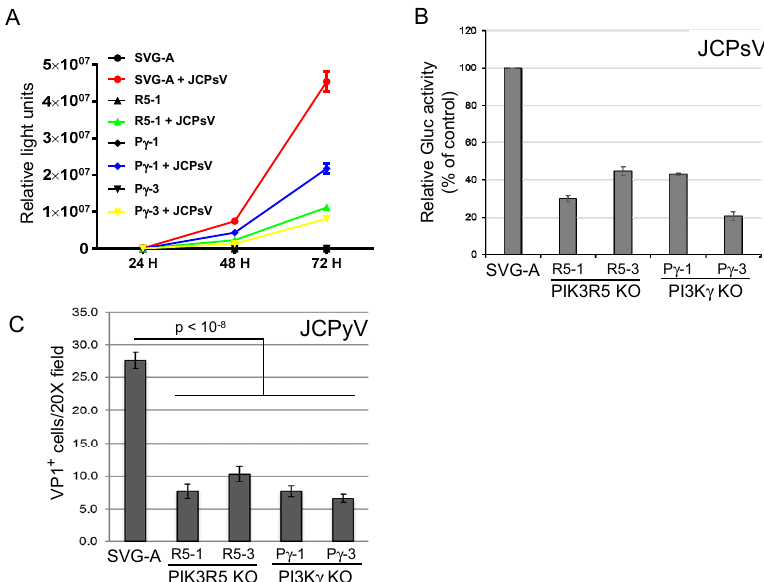
Figure 2. PI3K γ and PIK3R5 knockout inhibits JC polyomavirus infection. ( A ). Parental SVG-A cells or PI3K γ (P γ -1 and P γ -3) or PIK3R5 (R5-1) knockout cells were mock-infected or infected with JCPsV-Gluc. At the indicated times post-infection, luciferase activity in the medium was measured in triplicate. ( B ). Parental SVG-A cells or PI3K γ or PIK3R5 knockout (KO) cells were infected with JCPsV-Gluc.